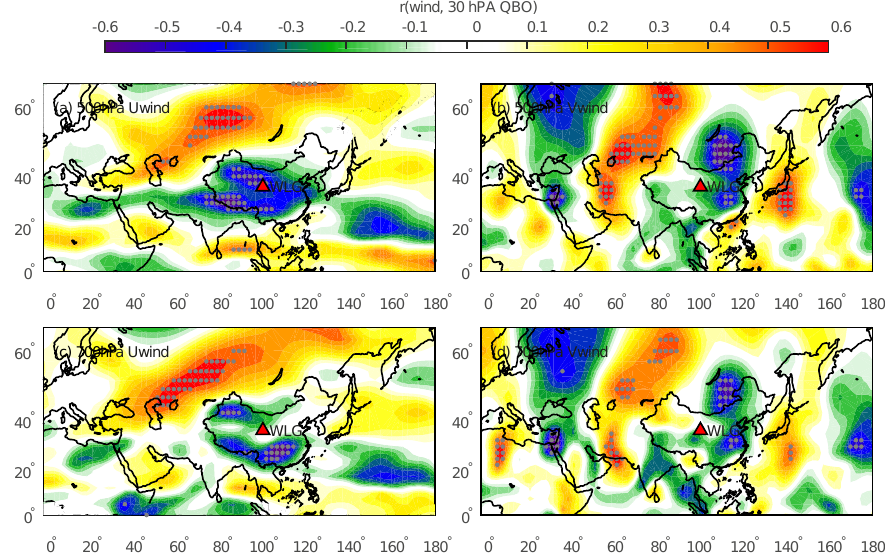
Figure 14. Correlation coefficients between the QBO index and zonal (a, c) and meridional (b, d) wind at 500 and 700hPa with grey dots indicating those that are significant ( p < 0 . 05). The red triangles indicate the position of